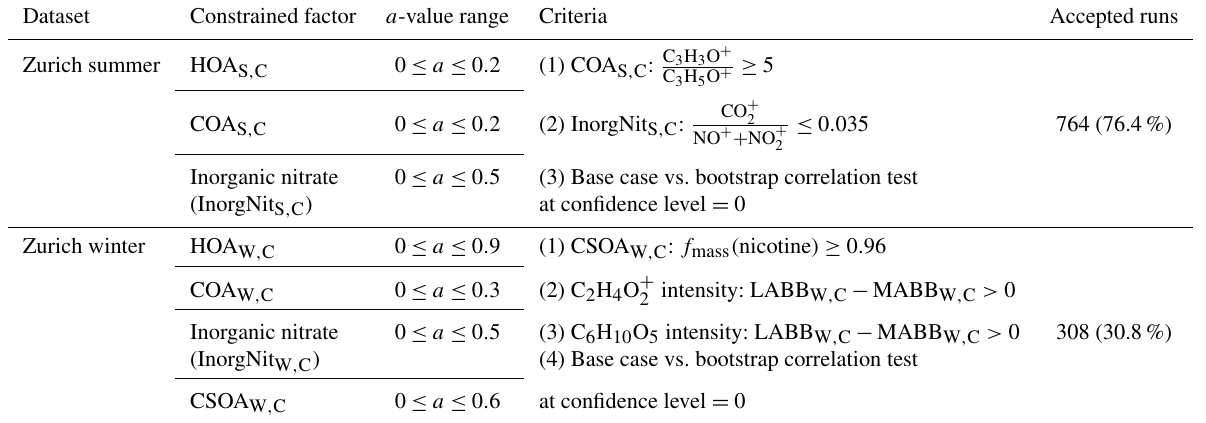
Table 2. Summary of a -value range for constrained factors, criteria for a value range and accepted bootstrap run selection, and the number of accepted runs from the final combined bootstrap and a -value analysis for the summer and winter